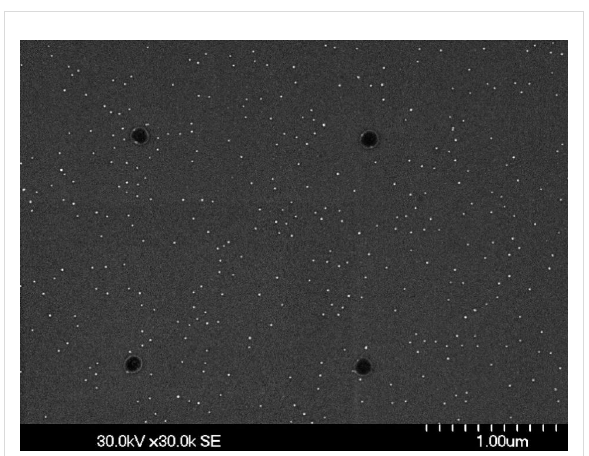
Figure 3: SEM image of resist disks arranged in a square (dark contrasts) as obtained after development (step 3 in Figure 2). The bright dots image the still present residual Au NPs, which have completely lost their hexagonal order during removal of the unex- posed